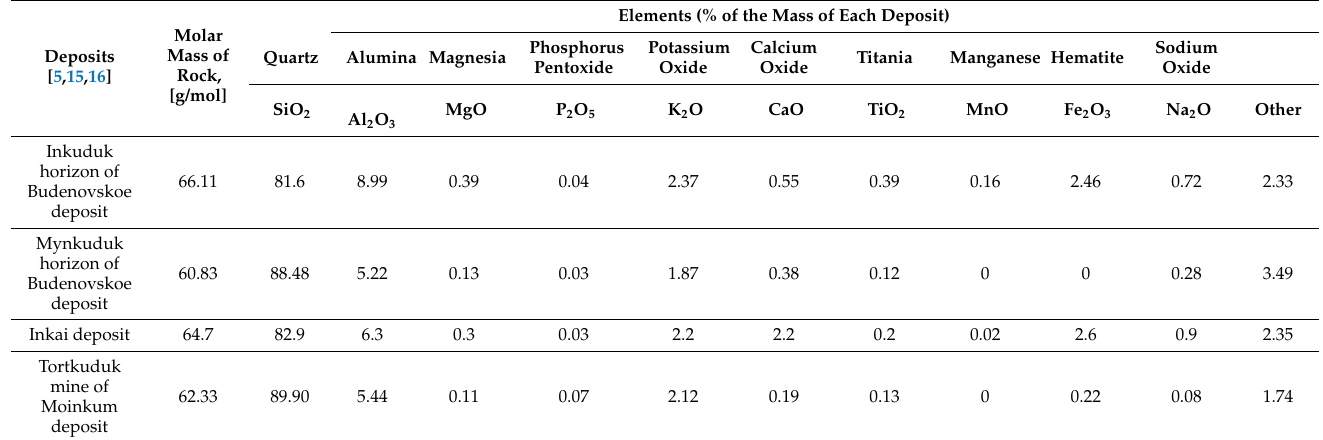
Table 1. Ore composition of some uranium deposits in